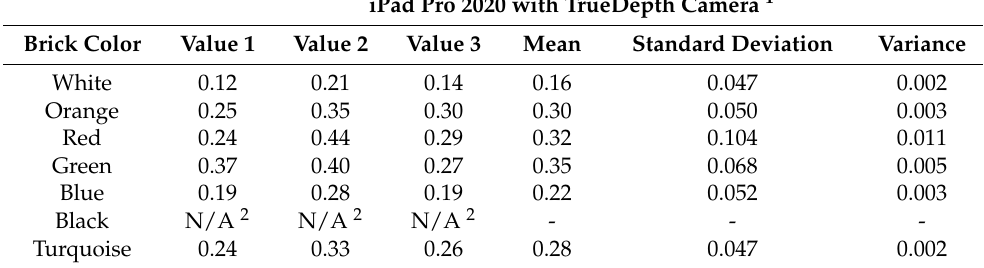
Table A2. Determined flatness values of seven different colored Lego bricks scanned by iPad Pro (2020) using TrueDepth.